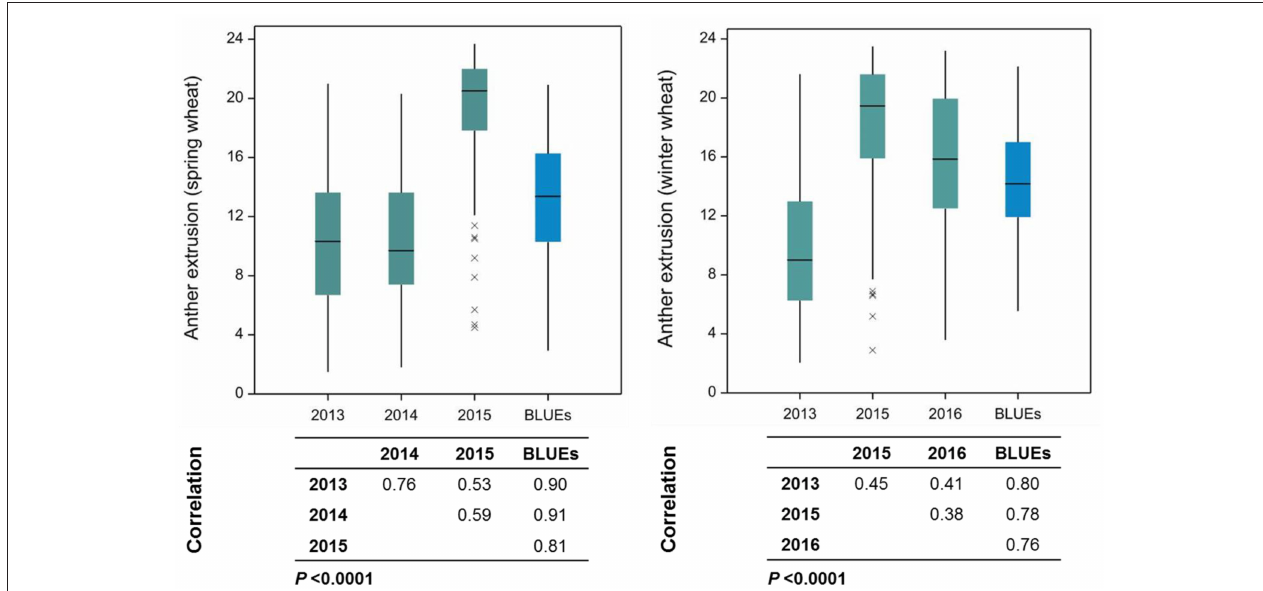
FIGURE 1 | Boxplots and Pearson’s product moment correlations among growing years and their Best Linear Unbiased Estimates (BLUEs) in spring and winter wheat panels. Numbers on the Y-axis represent the number of extruded anthers. xs indicate the outlier accessions.